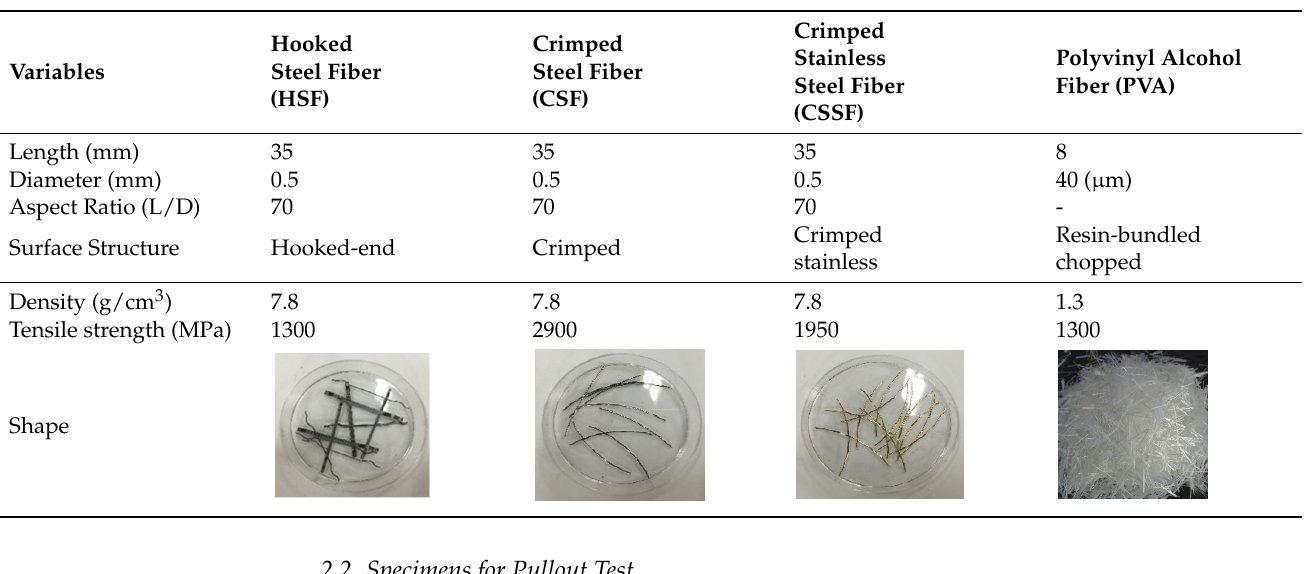
Table 2. The properties of different fibers.